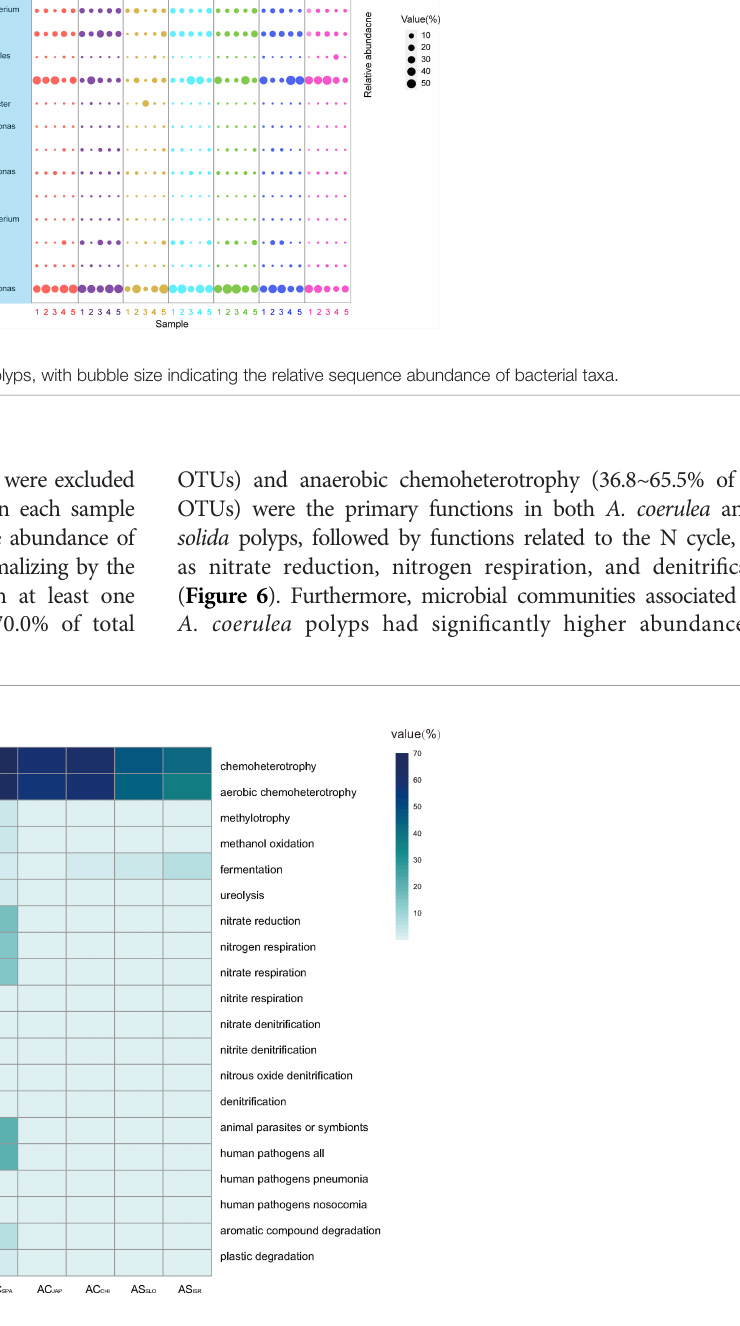
FIGURE 6 | Heatmap matrix on the top 20 functional groups with the highest cumulative OTU relative sequence abundance in Aurelia polyp samples based on analysis of